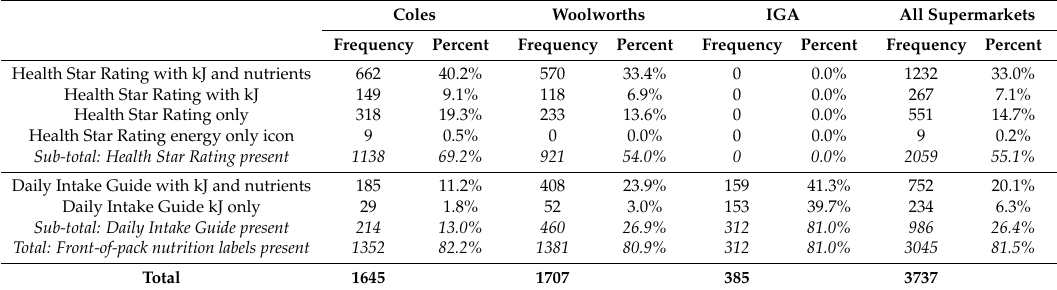
Table 2. Front-of-pack nutrition labels present on supermarket own brand foods in Australia.